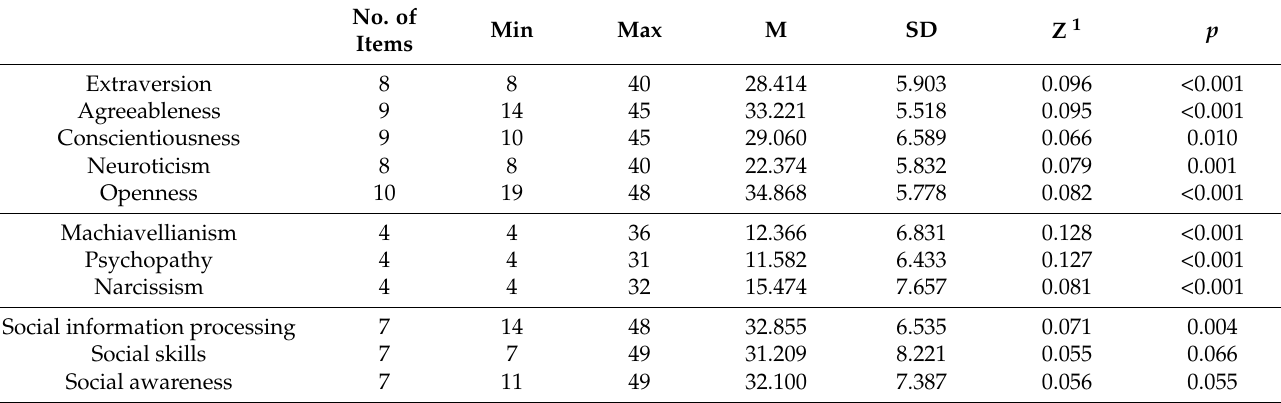
Table 1. Descriptive statistics.